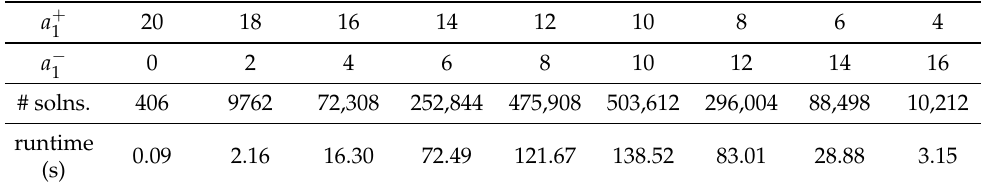
Table 1. Number of tiling solutions (# solns.) and runtimes in seconds for CPLEX to find the feasible solutions of the pariomino tiling problem in Example